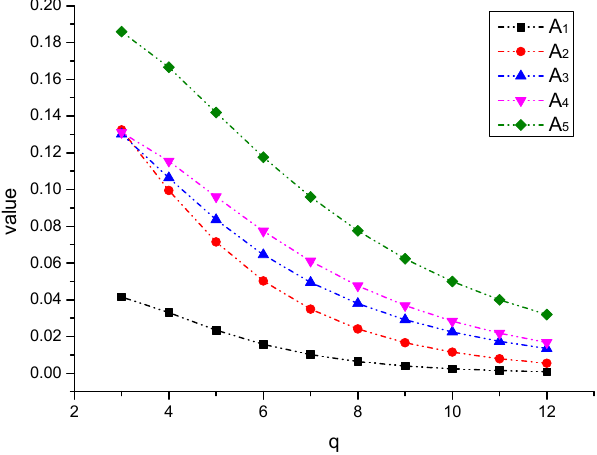
Figure 1. The influence of q -value change based on q-RONFWA operator on the sorting result.